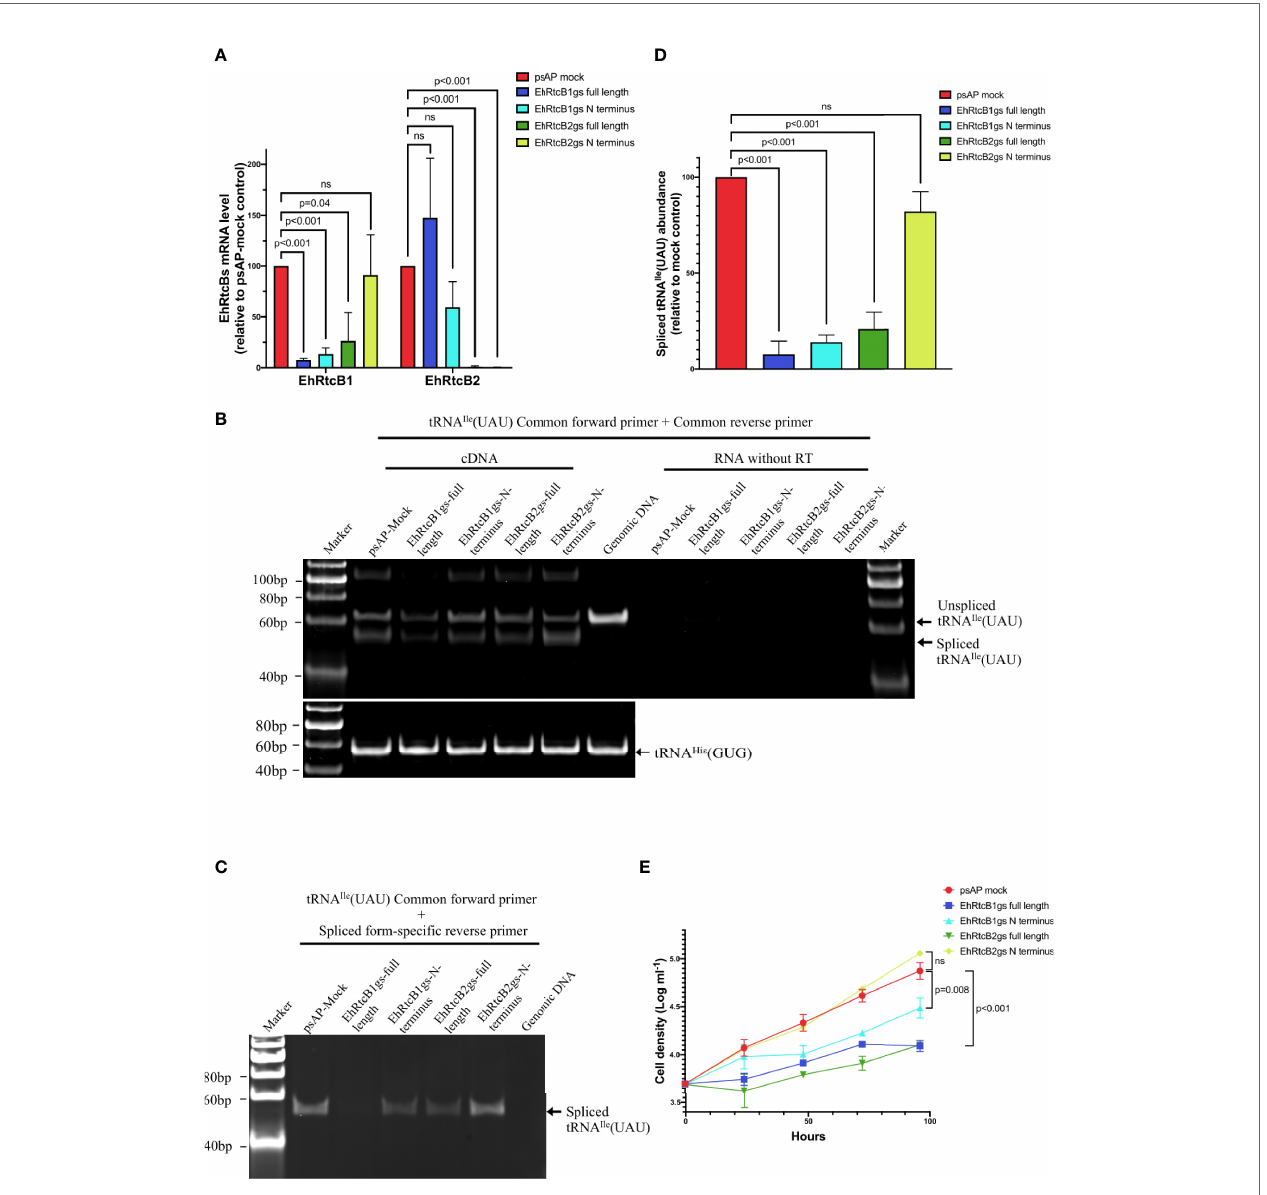
FIGURE 3 | Effects of gene silencing of EhRtcB s on tRNA splicing and cellular proliferation. (A) Veri fi cation of repression of mRNA levels of EhRtcB1 and EhRtcB2 by gene silencing. Two E . histolytica strains each for EhRtcB1 and EhRtcB2 gene silencing were produced using gene silencing plasmid constructs containing either full-length or N-terminal portion of the protein-coding region of EhRtcB1 and EhRtcB2 genes, by small RNA-mediated transcriptional gene silencing, as described in Materials and Methods . The levels of mRNAs of each EhRtcB1 (A) and EhRtcB2 (B) gene were normalized against those of RNA polymerase II and then are shown relative to psAP mock control. (B, C) Effects of EhRtcB s gene silencing on tRNA Ile (UAU) splicing. Unspliced and spliced tRNA Ile (UAU) were ampli fi ed by a combination of common forward and reverse primers (B) or by a combination of common forward and spliced form-speci fi c reverse primers (C) and detected after electrophoresis. tRNA His (GUG) was used as negative control, which does not contain an intron (only in B ). (D) Quantitation of spliced tRNA Ile (UAU) by qRT-PCR. The amounts of spliced tRNA Ile (UAU) from each gs strain were normalized against those of tRNA His (GUG) and then are shown relative to that in psAP mock control. (E) Growth kinetics of EhRtcB s gene silenced and control strains. The proliferation of trophozoites was monitored by cell number counting at 0, 24, 48, 72, and 96 h. Unpaired t-test was performed to determine all the statistically signi fi cant difference. P values are shown. ns, not signi fi